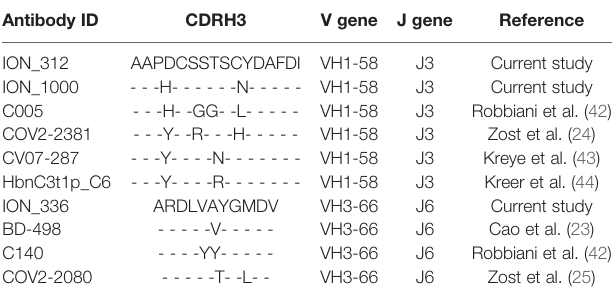
TABLE 3B | Convergence of antibody sequences across separate